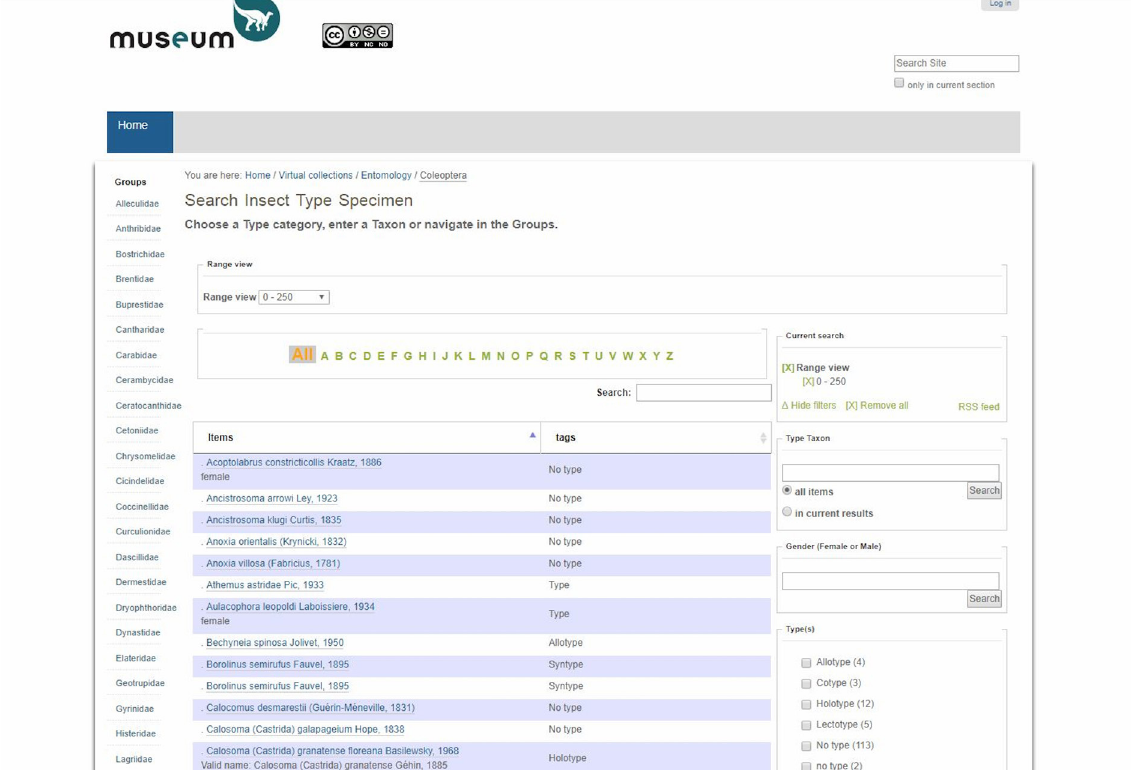
Fig. 8.3. Virtual collections page of RBINS